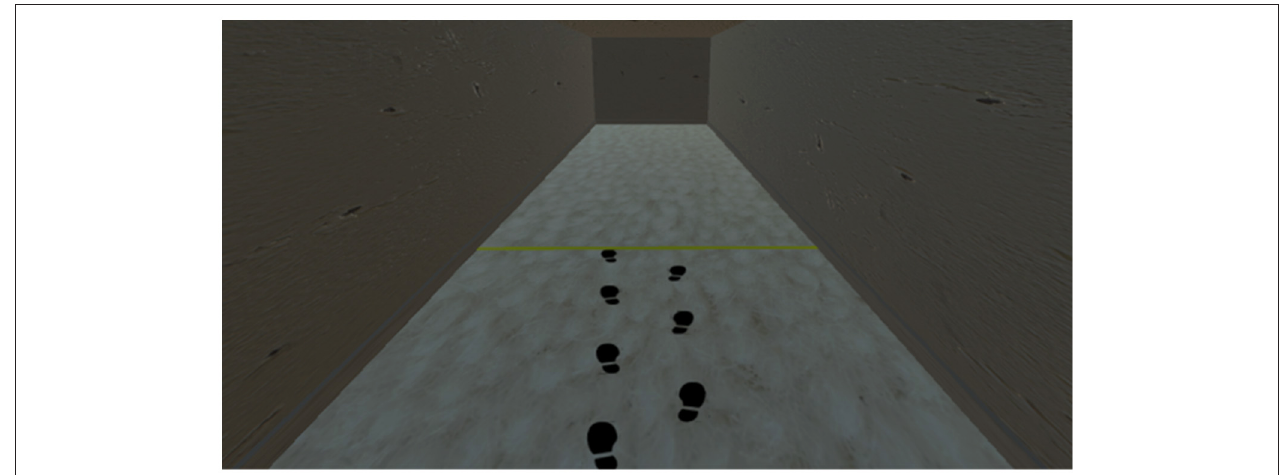
FIGURE 2 | Screenshot of the participant’s view of the hallway during a practice trial that included a spatial only cue.